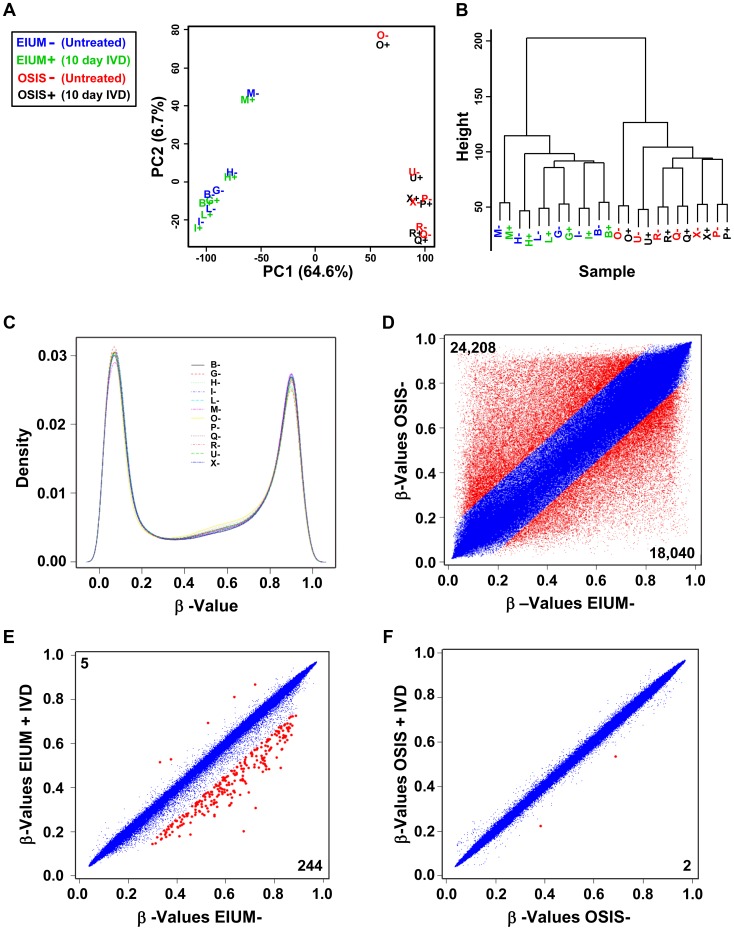
The global CpG methylation pattern in healthy and endometriotic stroma.The methylation in EIUM (n = 6) and OSIS (n = 6) with (+) or without (−) IVD was examined by (A) principal component analysis and (B) hierarchical clustering based upon on the 470,540 probes from the methylation array (letters B, G, H, I, L, and M denote EIUM; O, P, Q, R, U, and X, denote OSIS). The normalized density estimation was determined (C) from the β-values of all 12 untreated samples. Scatter plots compare the β-values for individual CpGs between (D) EIUM- and OSIS-, (E) EIUM+ and EIUM-, and (F) OSIS+ and OSIS−. Data plotted in red differed in average β-value by at least 0.15. Numbers in the upper left and lower right corners of each plot show the total number of hyper- and hypomethylated CpGs, respectively.